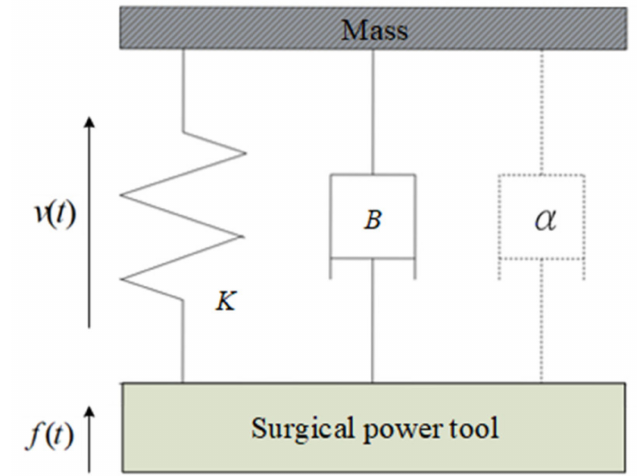
Figure 3. Schematic diagram of a virtual